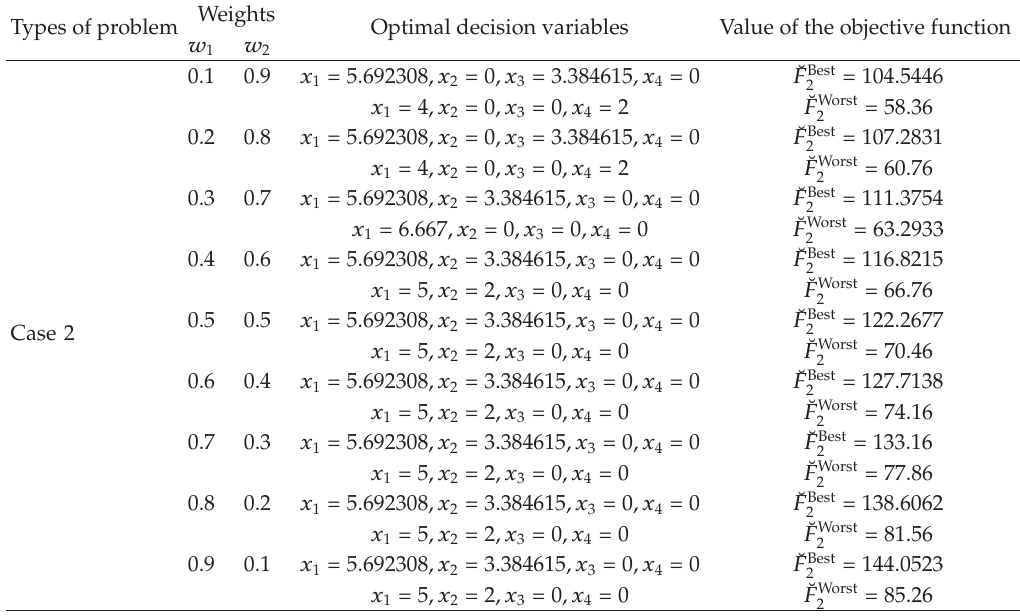
Table 2: Optimal solution for Case